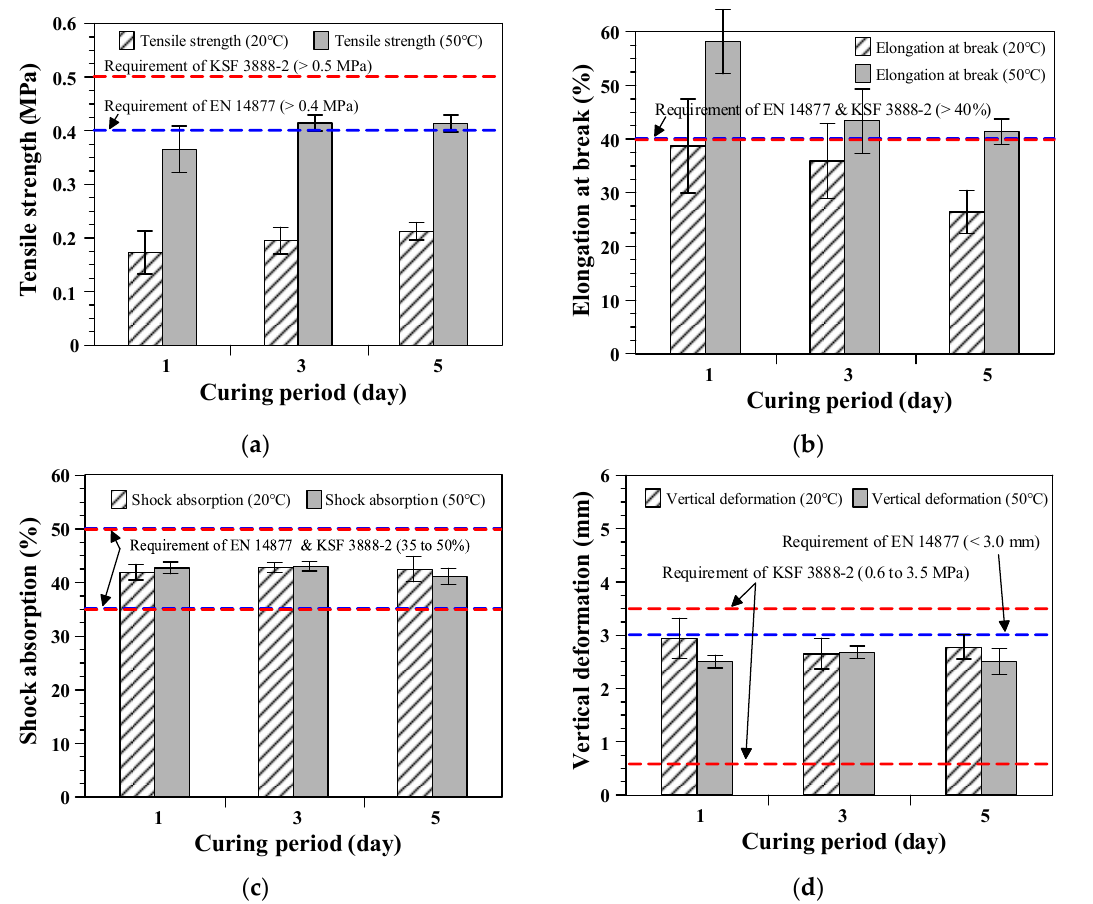
Figure 7. Effects of the curing age: ( a ) Tensile strength; ( b ) elongation at break; ( c ) shock absorption; and ( d ) vertical deformation.